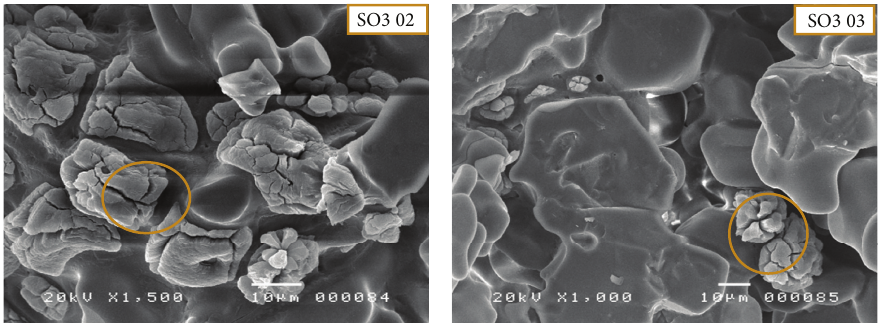
Figure 7: SEM images show the free lime in the grains of white